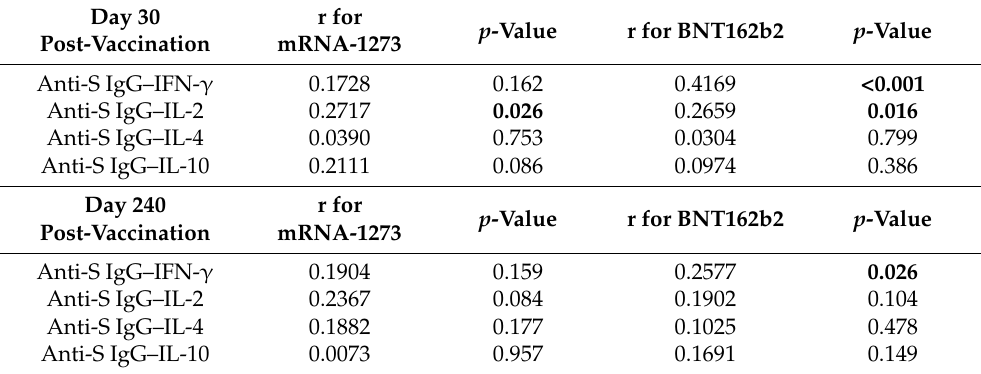
Table 5. Correlation between humoral and cellular responses on days 30 and 240.